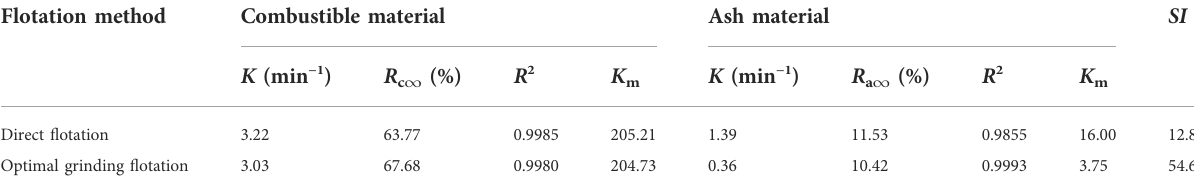
TABLE 2 Output of non-linear regression fi tting to fi rst-order rate equation for a recovery rate of combustible and ash materials for fl otation concentrate. Flotation